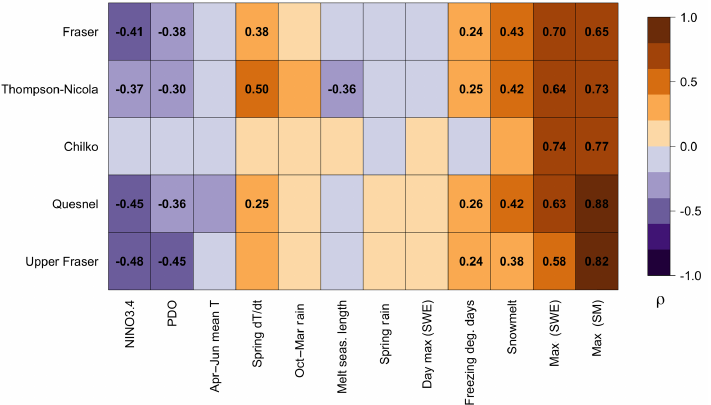
Figure 7. Correlogram of observed and VIC-simulated variables, averaged over each of the indicated subbasins within the 1955–2004 period, against APF at the subbasin outlet (Table 1). The cell values and colour scale indicate Spearman rank correlations, significant at the p < 0.1 level. The ordering of variable columns is the same as in Fig. 6, for ease of